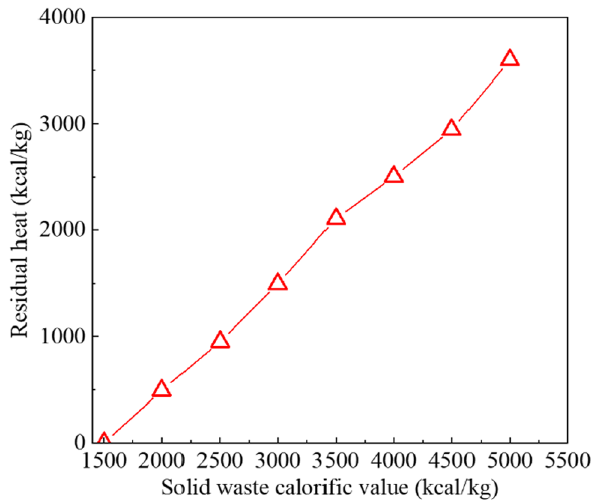
Fig. 6 Residual heat in the gas